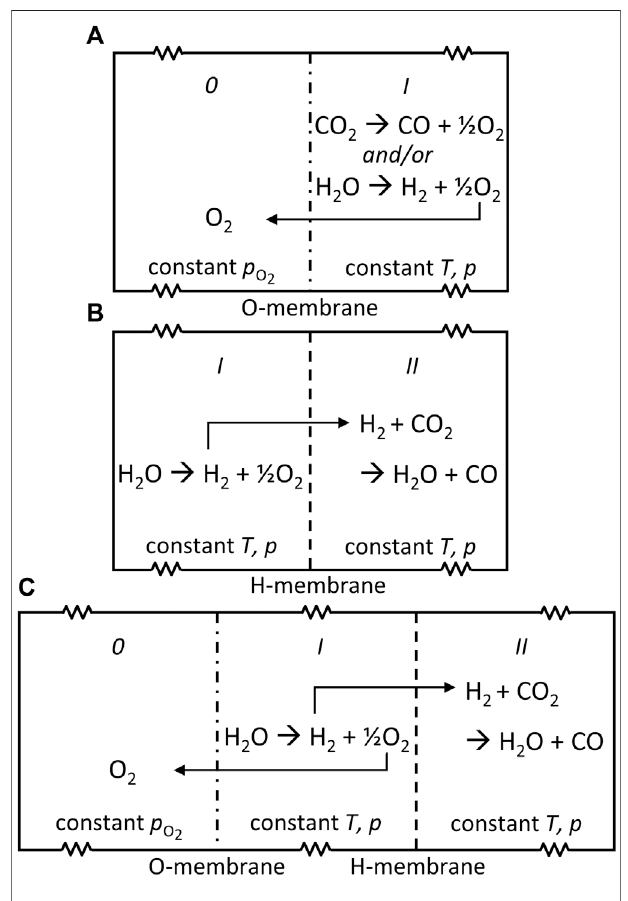
FIGURE 1 | Schematics of three con fi gurations for the net thermochemical splitting of CO 2 to CO and O 2 : (A) oxygen-membrane reactor, (B) hydrogen-membrane reactor, and (C) dual-membrane reactor. A spring symbol is used to indicate the free adjustment of volume in each chamber to maintain constant p